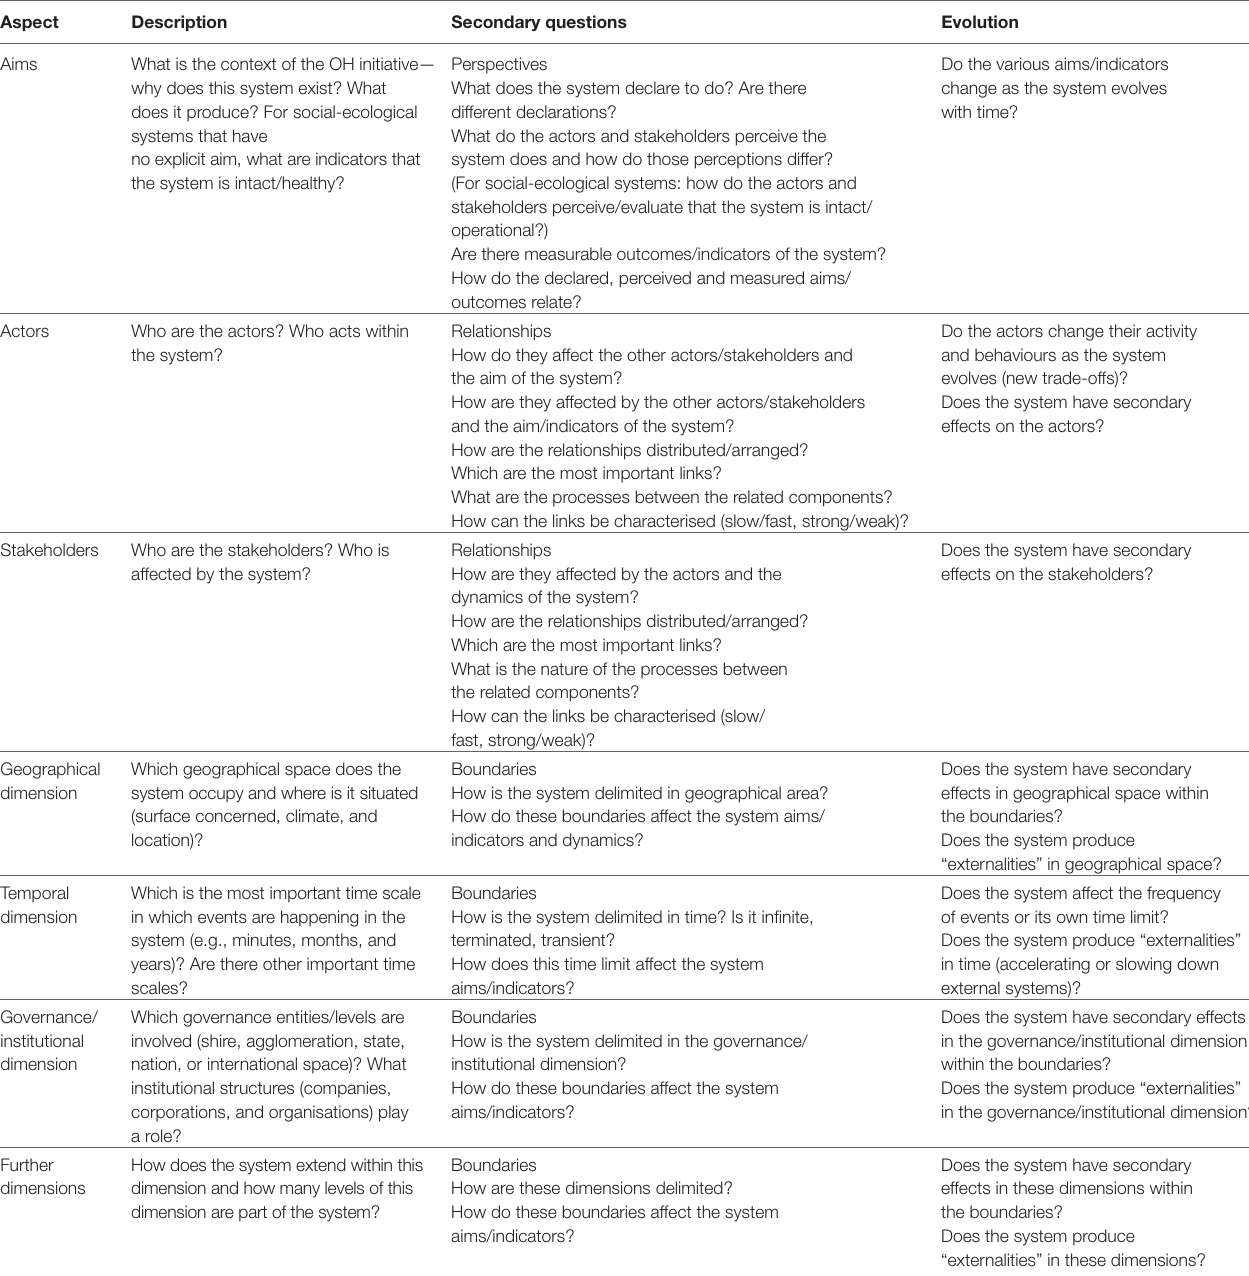
tAbLe 2 | An overview of how to describe the system at which the One Health (OH) initiative is targeted, i.e., the context of the